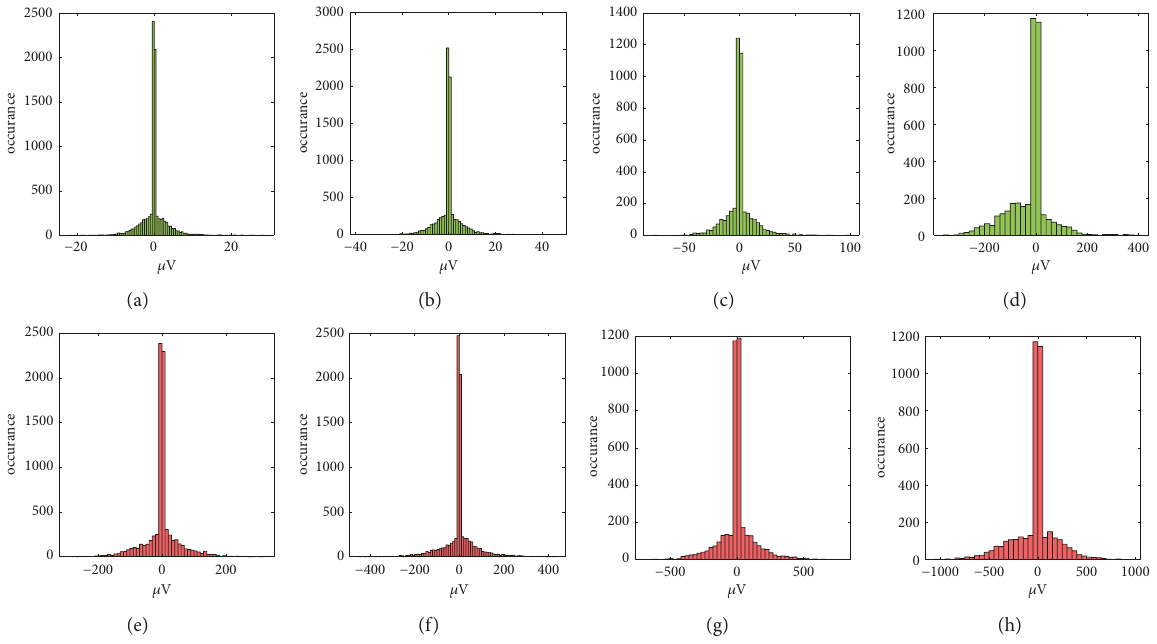
Figure 2: Illustration of seizure-free and epileptic seizures of subbands obtained from TQWT with Q = 1, r = 3, J = 3 . Figures (a), (b), (c), and (d) represent the first, second, third, and fourth subbands obtained from seizure-free signals. Figures (e), (f), (g), and (h) represent the first, second, third, and fourth subbands obtained from the epileptic